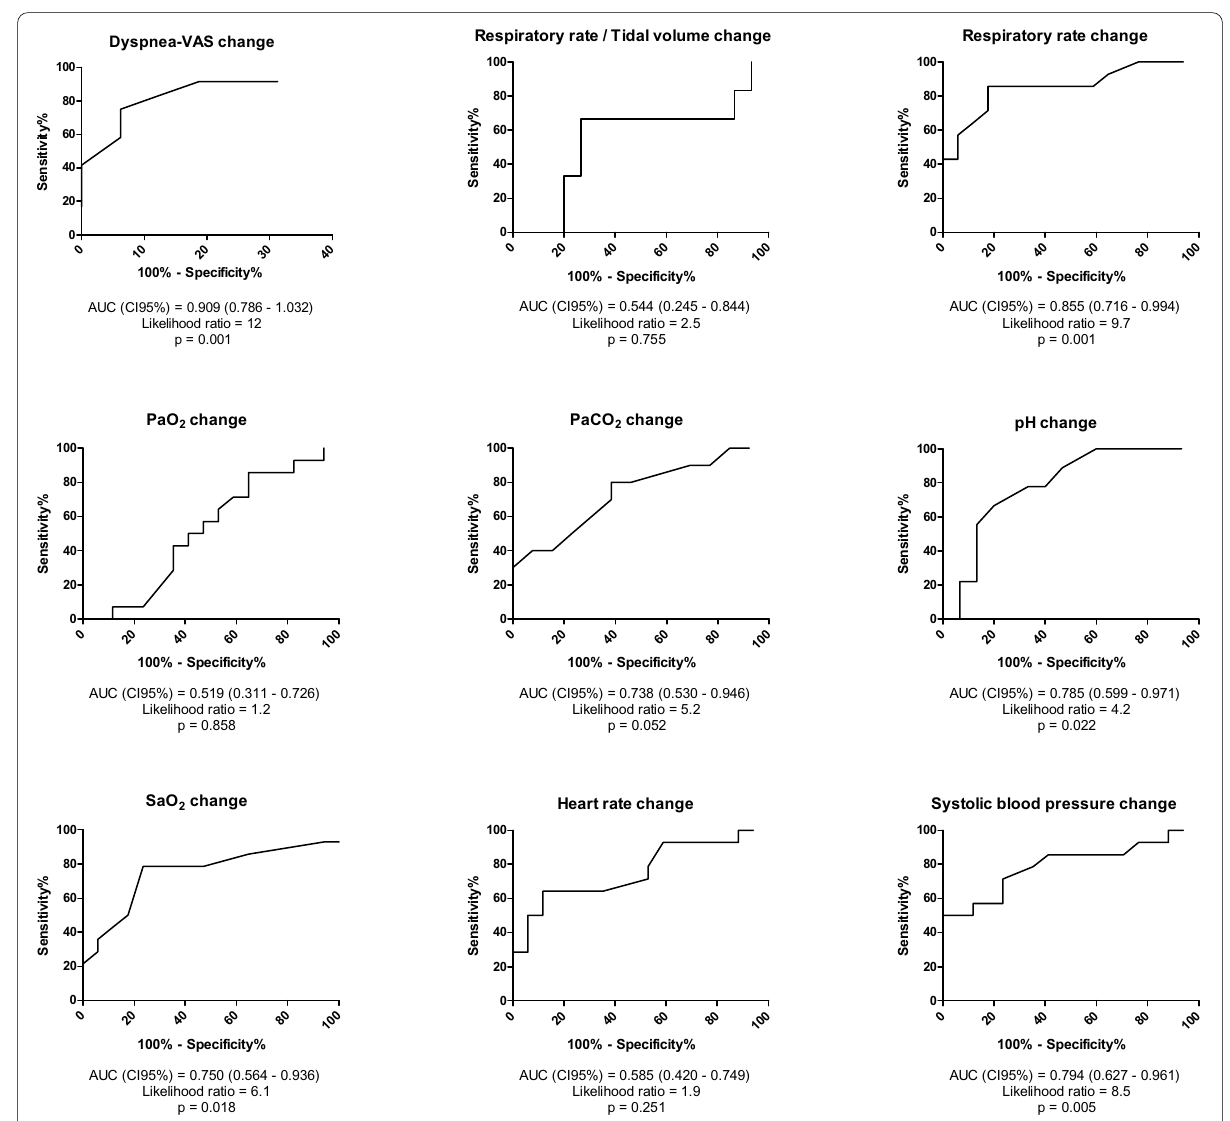
Fig. 1 Receiver operating characteristics curve of changes in Dyspnea-Visual Analog Scale (VAS), breathing pattern, blood gas and hemodynamics to detect spontaneous breathing trial failure. Change is expressed as the difference between value at the initiation and end of the spontaneous breathing trial. Dyspnea-VAS Dyspnea-Visual Analog Scale; SaO 2 arterial saturation of